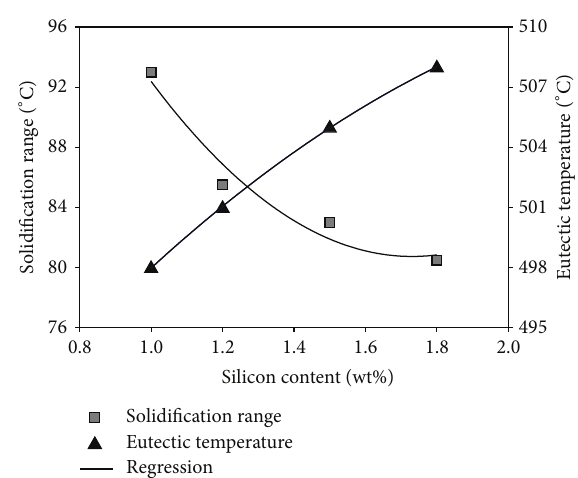
Figure 5: Effect of cooling rate and Si content on SDAS of Al-Zn-Si alloys.